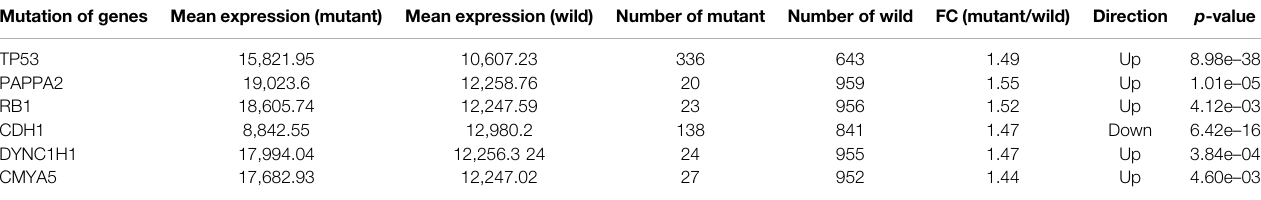
TABLE 4 | The six mutant genes most strongly associated with PGK1 expression.